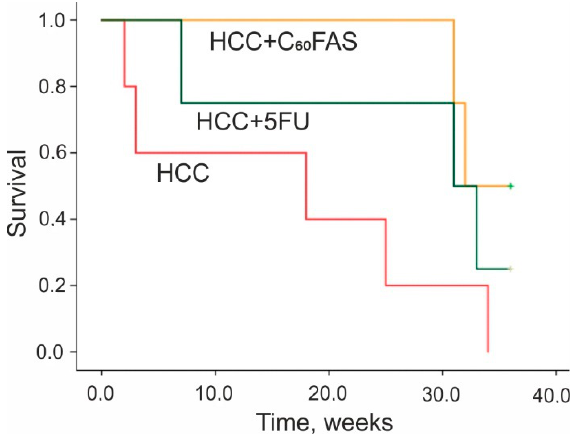
Figure 4. Kaplan–Meyer post-treatment survival curves for HCC-experienced animals treated by 5FU